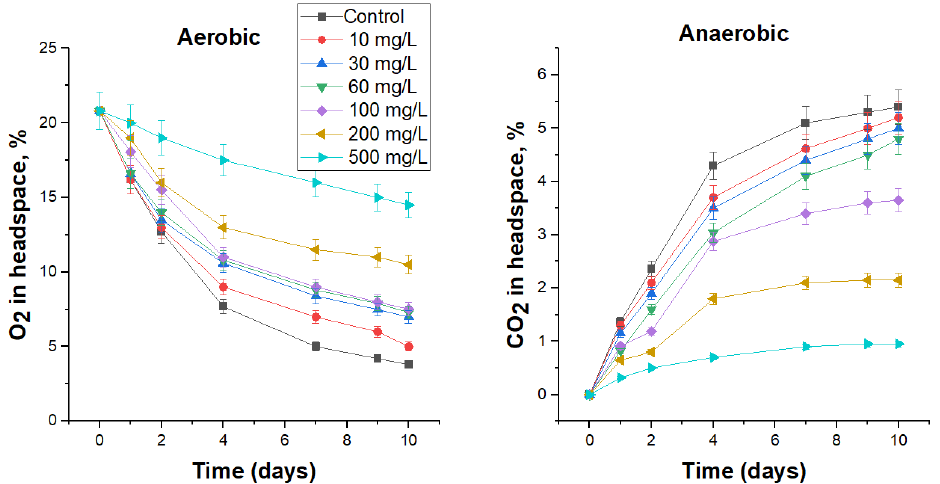
Figure 3. The effect of DBNPA on O 2 consumption under aerobic conditions and CO 2 production under anaerobic conditions by the respective microbial communities in FS.